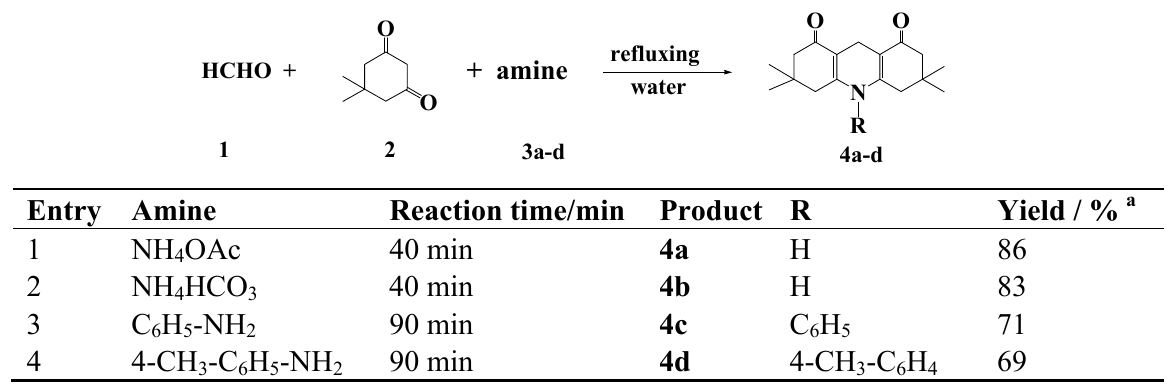
Table 1. Reaction time and yield for the reaction of different amines/ammonium